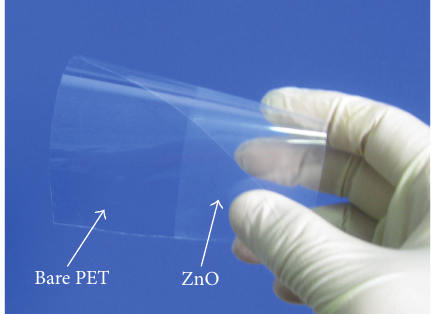
Figure 8: A photograph of a ZnO film prepared on a flexible PET